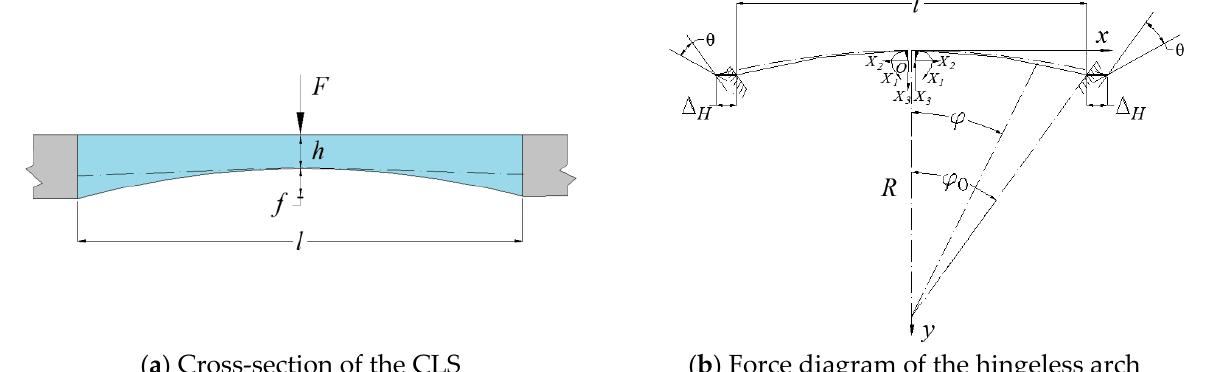
Figure 2. Simplified CLS structure.